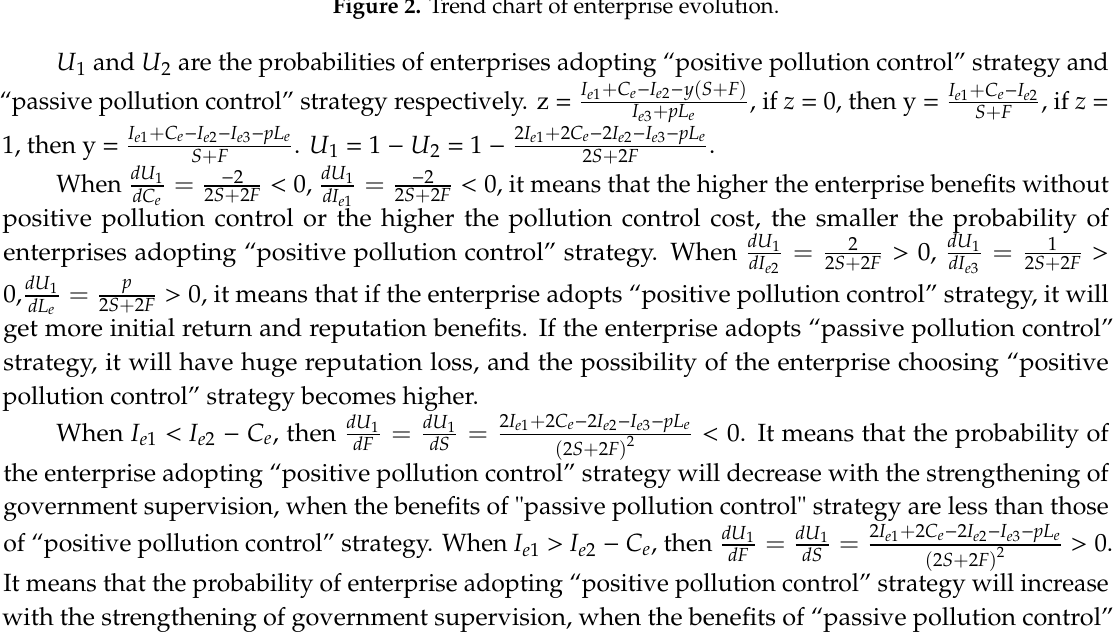
Figure 2. Trend chart of enterprise evolution.